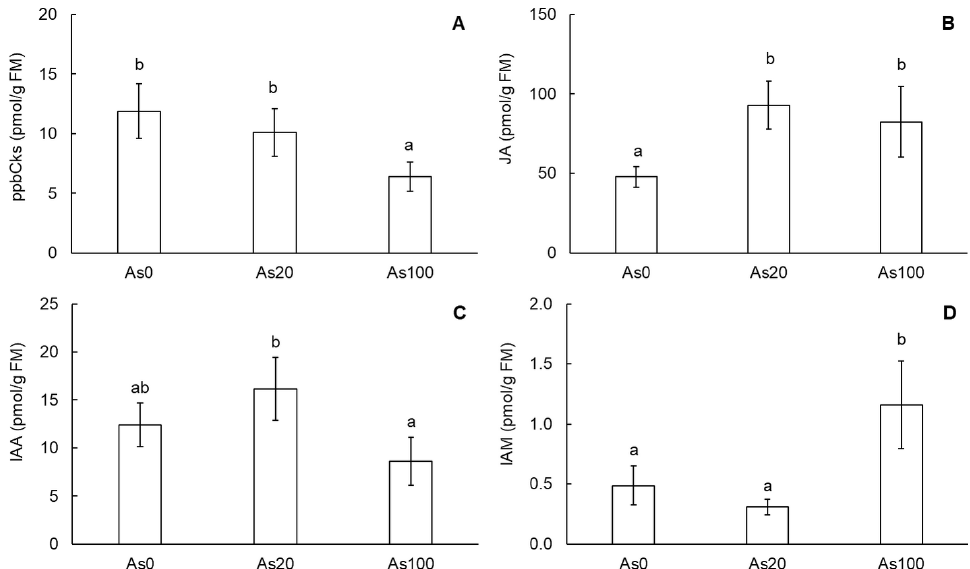
Figure 2. Content of primary products of cytokinins biosynthesis ( A ), jasmonic acid ( B ), indole ‐ 3 ‐ acetic acid ( C ) and indole ‐ 3 ‐ acetamide ( D ) in tubers of cherry radish. Values represent the mean ± SD. Data with the same letter are not significantly different. Different letters indicate significant differences ( p ˂ 0.05) among treatments according to ANOVA with Tukey’s post ‐ hoc test. Abbreviations: As0—0 mg As/kg soil (control); As20—20 mg As/kg soil; As100—100 mg As/kg soil; FM—fresh matter.